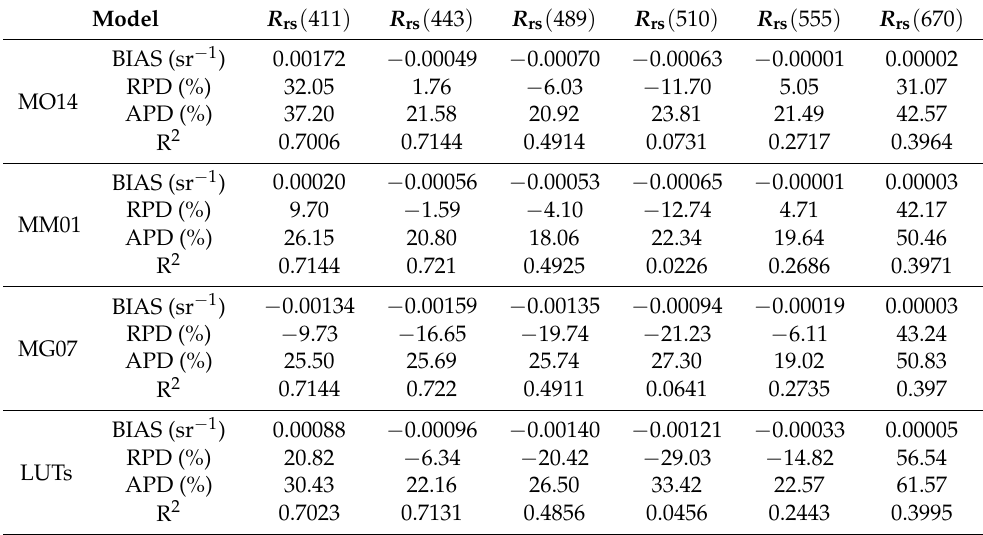
Figure 8. Performance of MM01, MG07, MO14 and LUTs models using the NOMAD dataset (( a ) MO14, ( b ) MM01, ( c ) MG07, ( d ) LUTs). Table 1. Statistical parameter of MM01, MG07, MO14 and LUTs models using the NOMAD